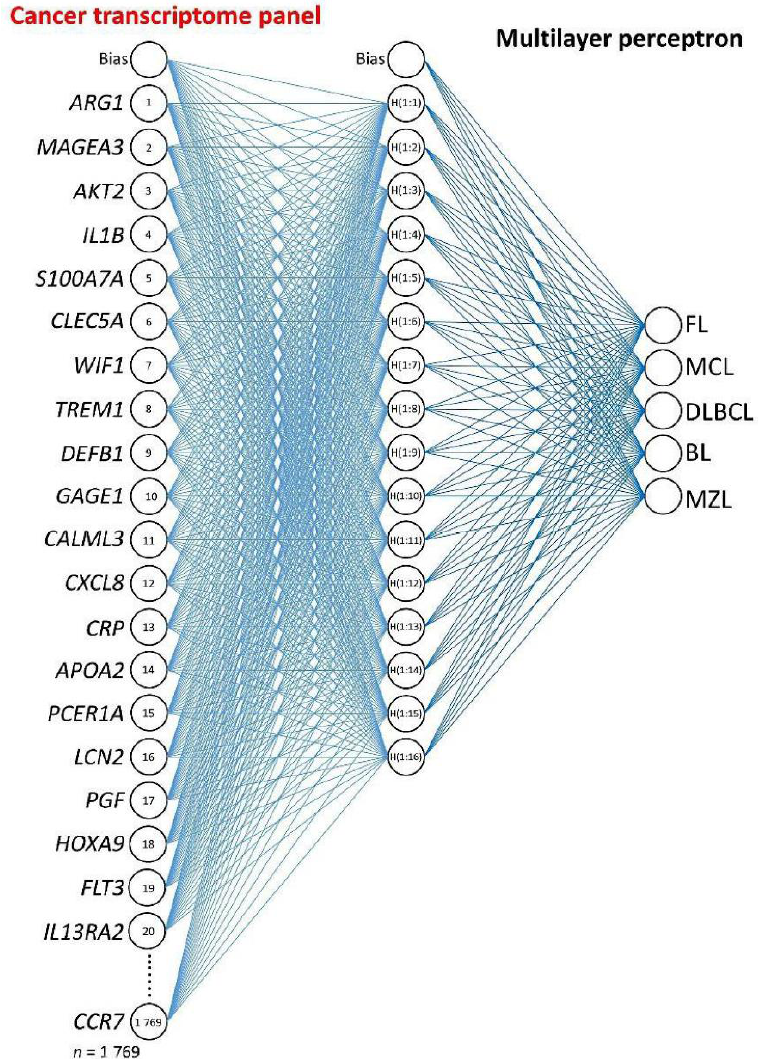
Figure 4. Network diagram of the MLP for predicting NHL subtypes based on a cancer transcriptome panel. This figure shows the architecture of the neural network used to input the gene expression of the cancer transcriptome panel ( n = 1769) and to output the 5 NHL subtypes. The top 20 genes are shown in order of importance according to their normalized importance for prediction.